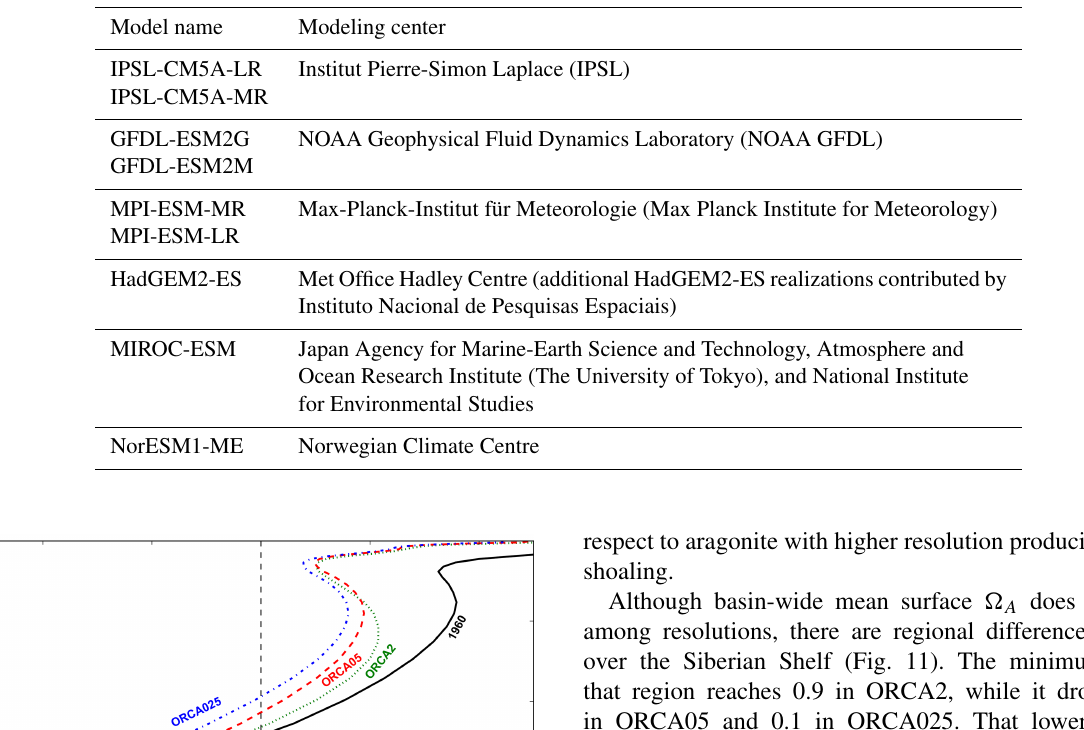
Table 8. CMIP5 models used in this study and the corresponding model groups.